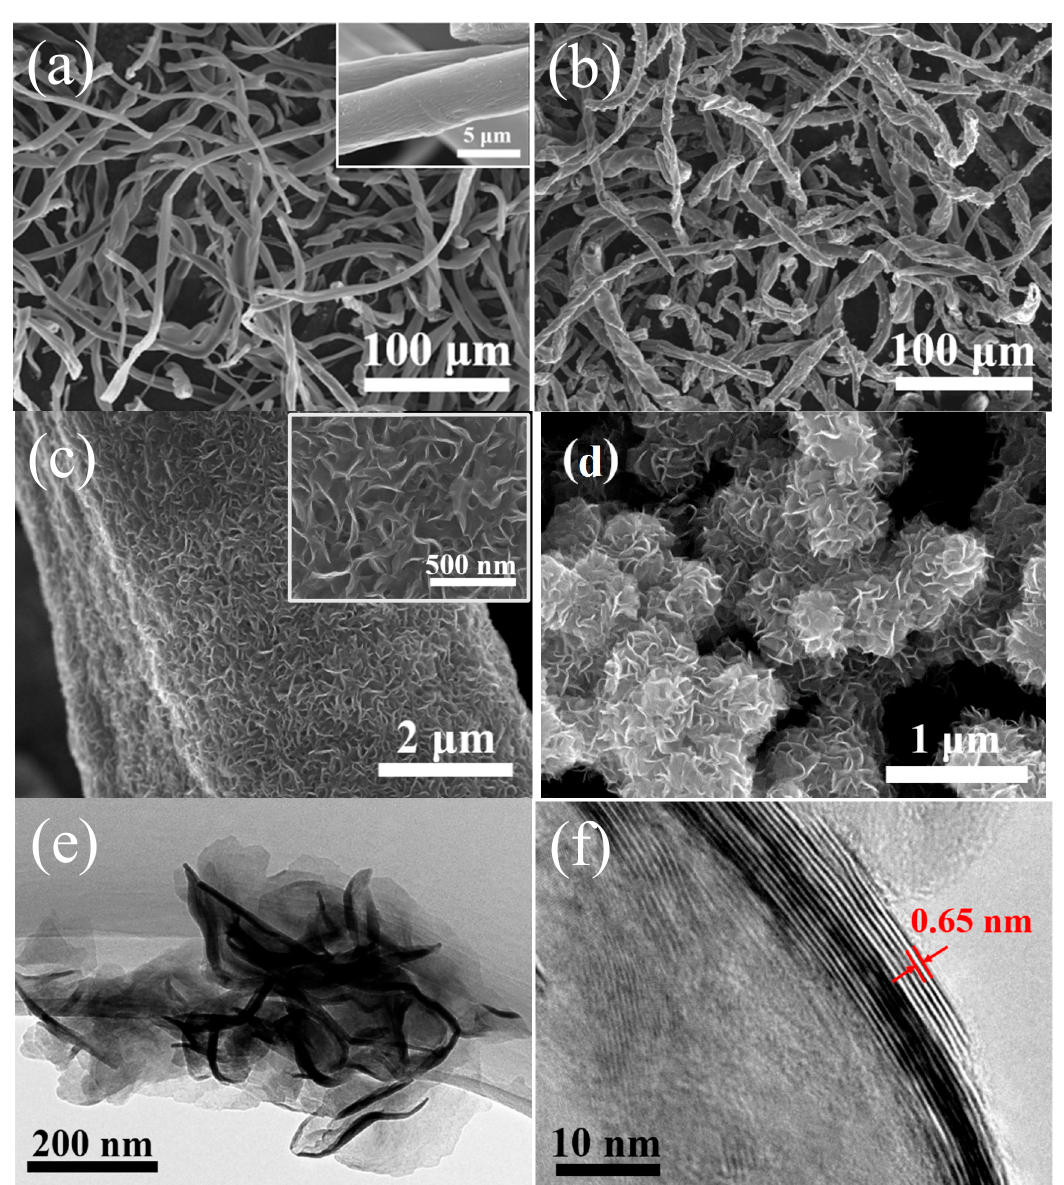
Figure 3. ( a ) Field emission scanning electron microscopy (SEM) image of pure cotton-derived carbon; ( b , c ) SEM images; ( e ) high-magnification transmission electron microscopy (TEM) image; and ( f ) high-resolution TEM (HRTEM) image of MoS 2 @carbon; ( d ) SEM image of pure MoS 2 .